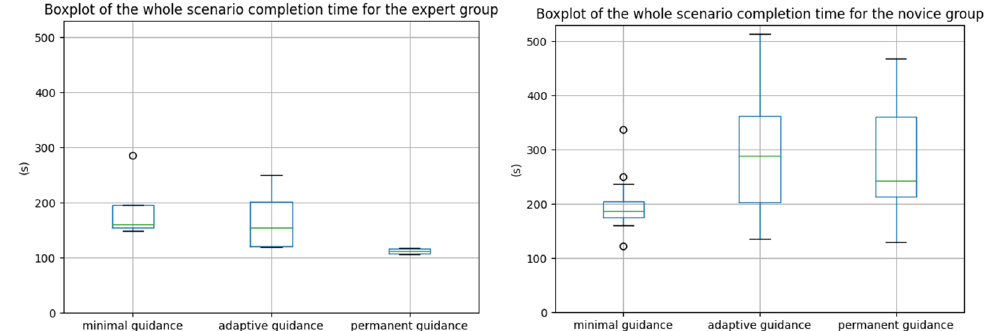
Figure 5. Boxplots by guidance type. On the left is the boxplot of the time participants took to visu- alize the target location and on the right is the boxplot of the time participants took to complete the whole scenario. Participants were significantly slower to find the target location with the adaptive guidance than with the permanent guidance. Participants were significantly faster to complete the whole task with the minimal guidance than with the adaptive and permanent guidances.H2 is not accepted nor rejected, and the boxplot of task duration in Figure 5 shows similar task duration be- tween the adaptive and permanent guidances. This suggests that participants wasted time (com- pared to the minimal guidance) in an equivalent manner for these two guidances. A hypothesis is that the time wasted when participants were waiting for the adaptive guidance is compensated by faster local tasks completion compared with the permanent guidance. This faster task completion may be because they were not disturbed by the wayfinding guidance with the adaptive guidance when performing local tasks, contrary to the permanent guidance. We cannot verify that partici- pants were indeed faster when performing tasks with the adaptive guidance or with the minimal guidance compared to the permanent guidance, because the variety of tasks to perform was high, and the different tasks needed different completion time. This made time completion between dif- ferent tasks impossible to compare. A future work would be to ensure similar local task difficulties for the three guidance temporalities evaluation. 5.3. Users Preferences To our surprise, no clear preference was set for any of the guidances. H3 is then nei- ther accepted nor rejected. This means that the three guidances have advantages and drawbacks for all the participants (see Table 6 for the details of participants’ grades).